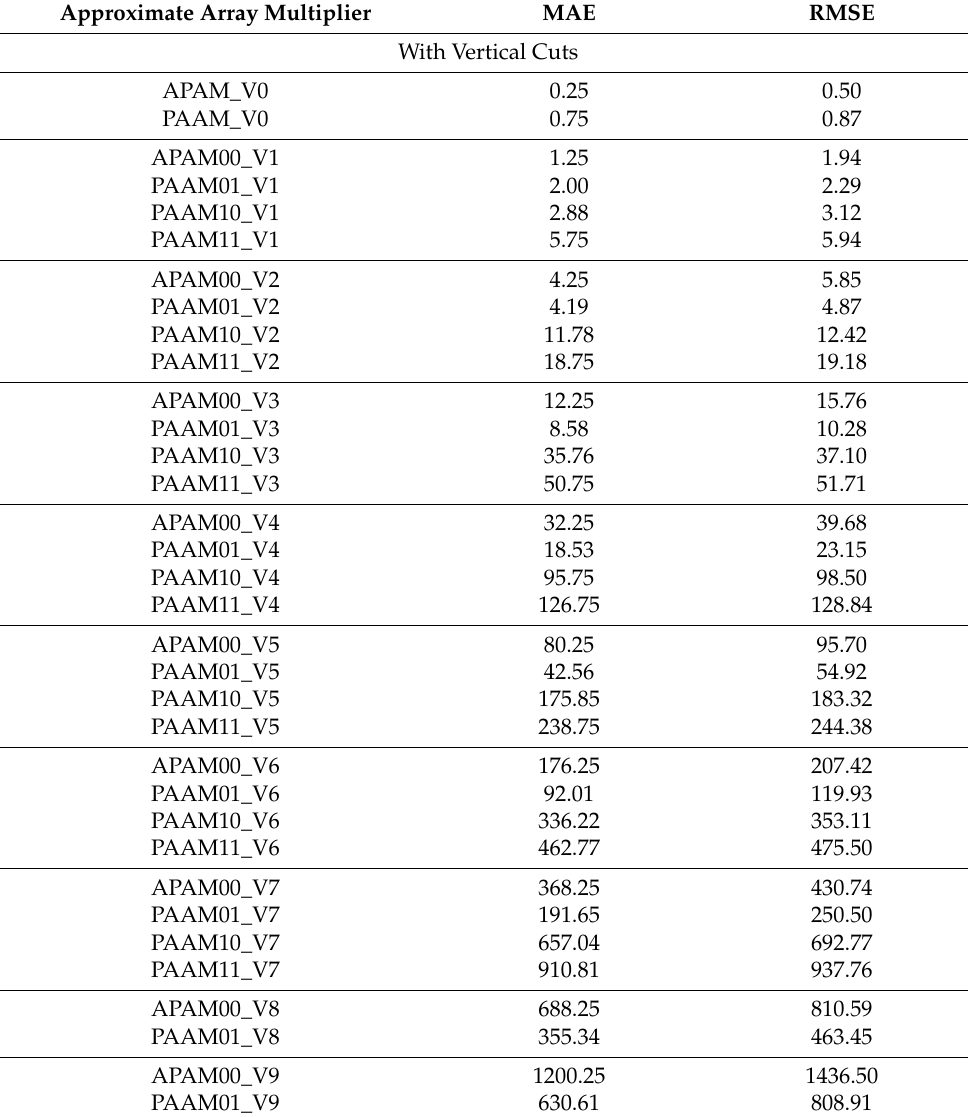
Table 1. Error parameters of various approximate array multipliers obtained via different vertical and horizontal cuts. Approximate Array Multiplier MAE